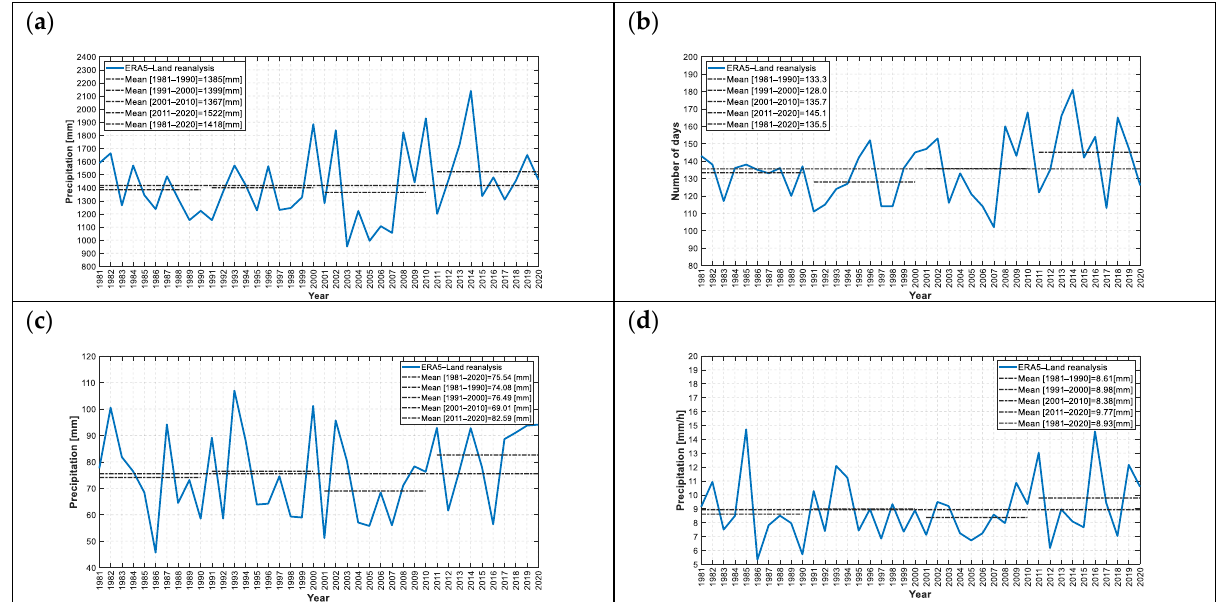
Figure 10. Precipitation analysis with ERA5-Land dataset (1981–2020): total annual precipitation ( a ), annual numbers of wet days with daily precipitation greater than 1 mm ( b ), 24-h annual maximum precipitation ( c ) and annual hourly maximum precipitation ( d ).